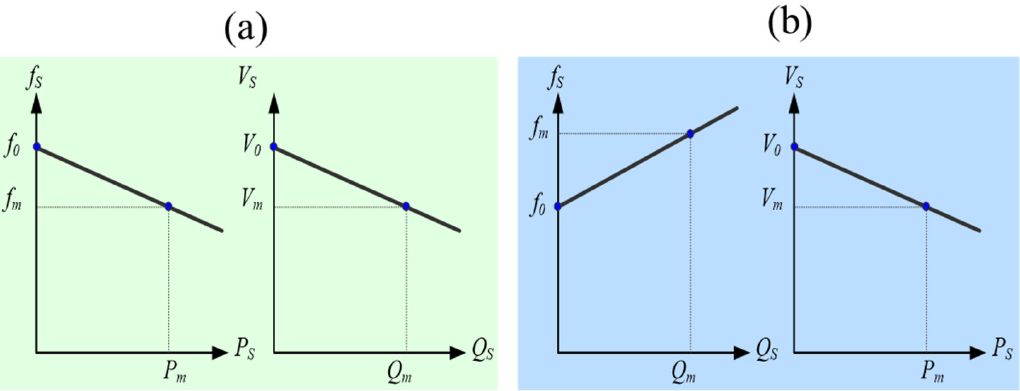
Figure 3. ( a ) Conventional and ( b ) reverse frequency and voltage droop control characteristics.